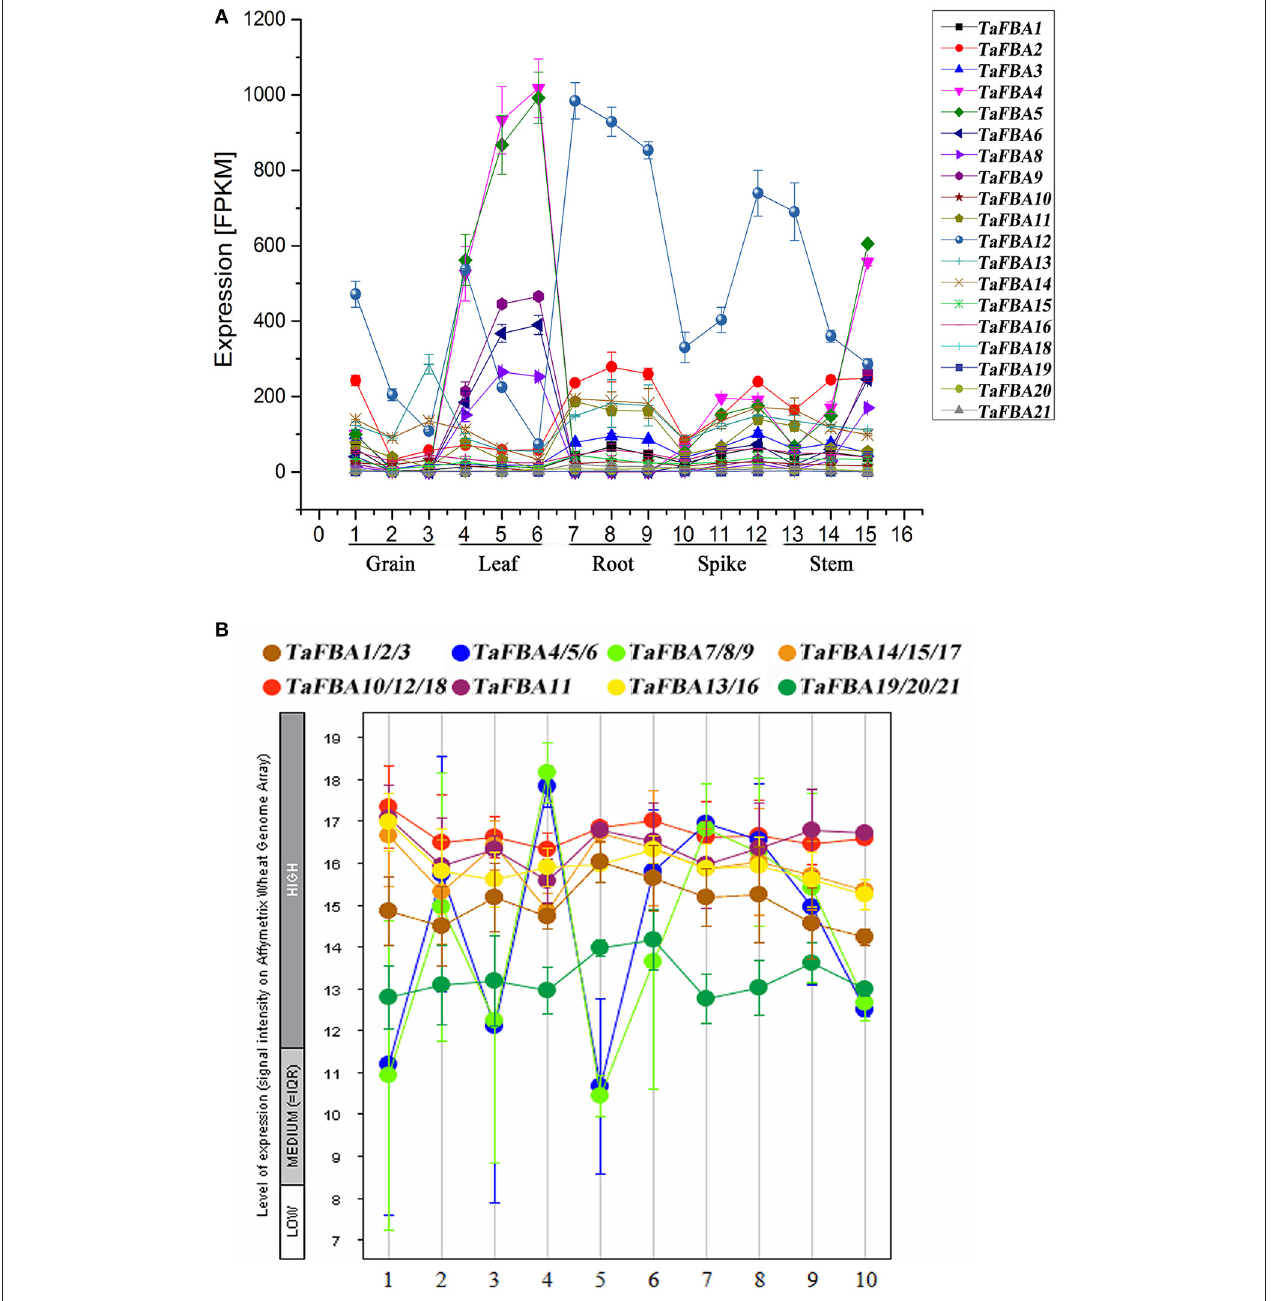
FIGURE 6 | Expression profiles of TaFBAs in different tissues and different developmental stages. (A) Expression profiles of TaFBA genes in different tissues. (B) Expression profiles of TaFBA genes at different development stages. Number 1–10 indicate: 1-germination, 2-seedling growth, 3-tillering, 4-stem elongation, 5-booting, 6-inflorescence emergence, 7-anthesis, 8- milk, 9-dough, and10- ripening stages respectively.